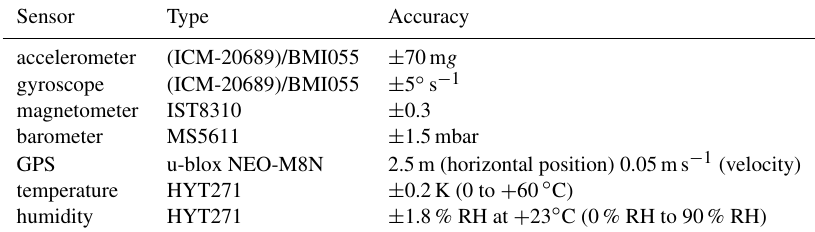
Table B1. Data sheet of the sensors. Accuracies representing the raw data output of the sensor without any processing of the Pixhawk autopilot.